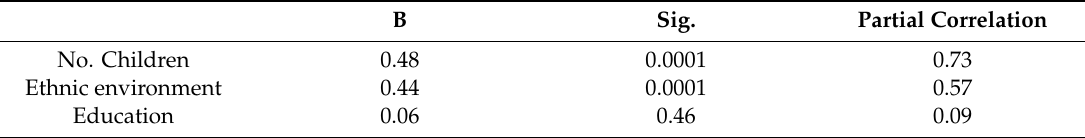
A Multidimensional regression between the best predictors of maternal stress and maternal stress. B Sig. Partial